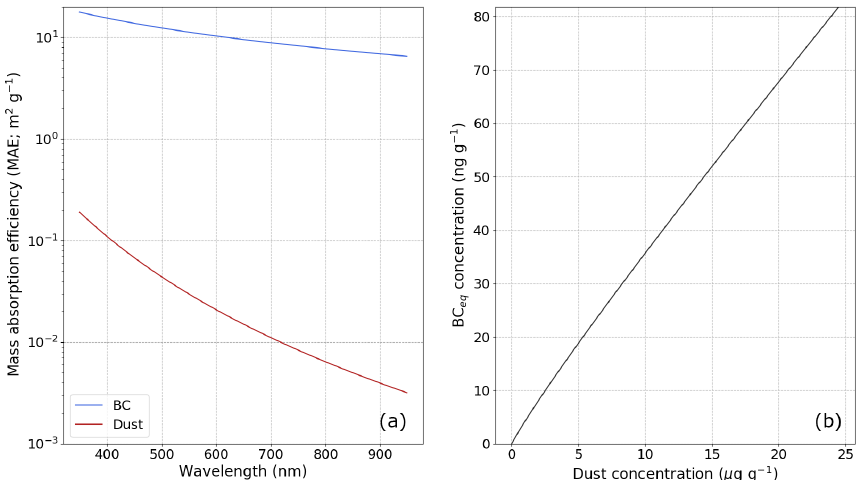
Figure 1. (a) Mass absorption efficiency (MAE) values of BC and dust used in the present study as a function of wavelength. (b) The eqBC concentration corresponding to a given dust concentration using these MAE values and the methods described in Sect. 3.1.